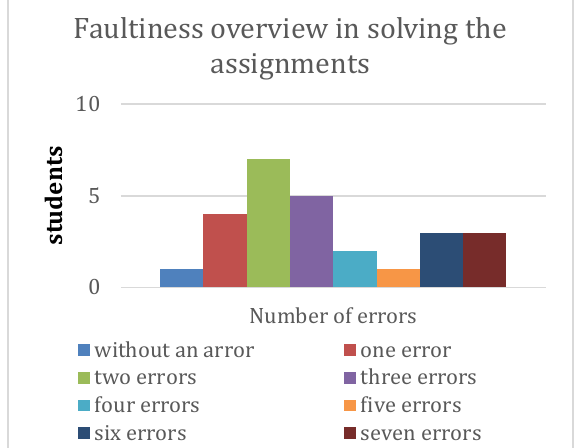
Table 10 The overview of the success rate by all respondents in task solving number of